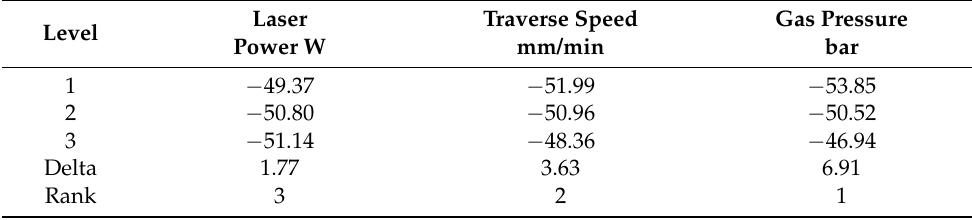
Table 5. S / N ratio smaller-is-better response table of input cutting parameters of the 2 mm thick